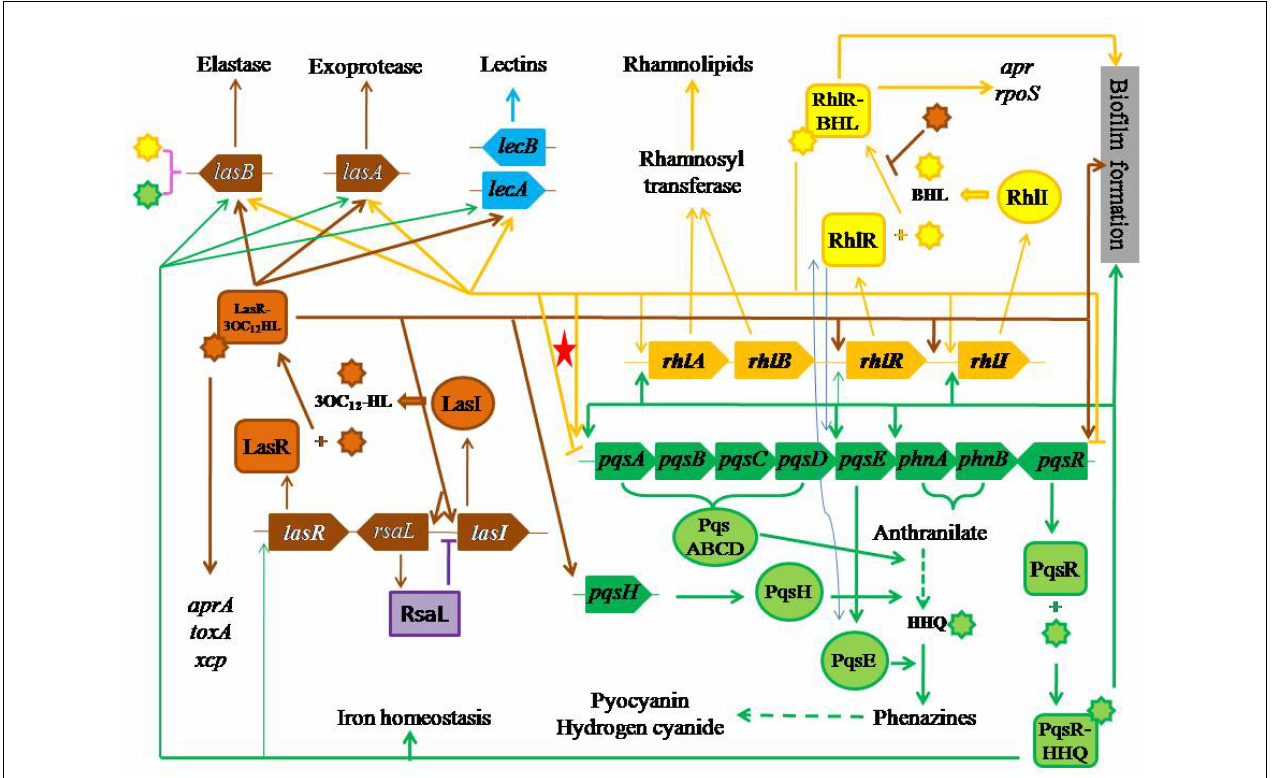
FIGURE 1 | Three QS systems with their effects and regulatory pathways. The red star highlights bi-functional regulation of RhlI–RhlR system to PQS